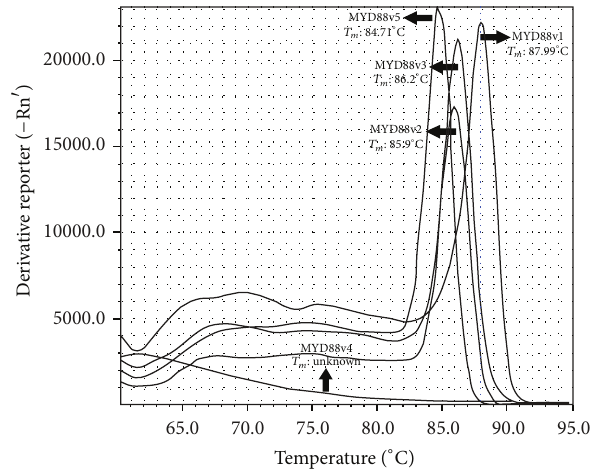
Figure 4: Melting curve analysis of MYD88 variants. Peaks show each variant and its melting temperature in ∘ C. Expression of MYD88v4 was not